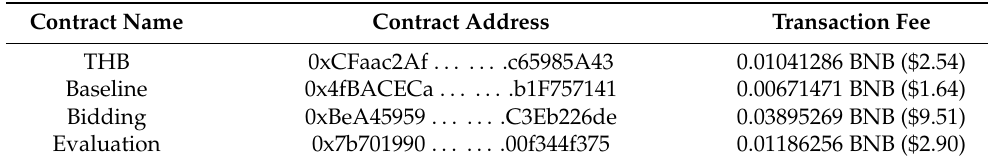
Table 5. Costs of smart contract deployments.